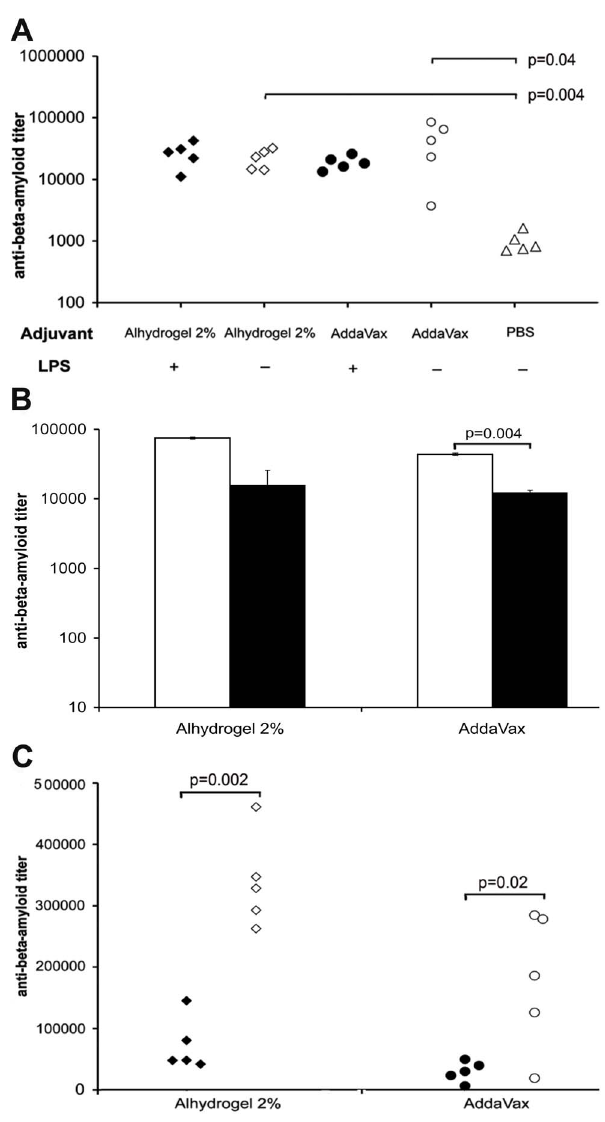
Figure 2. Titer and isotype of anti-A b antibodies induced by (1– 11)E2 formulated in Alhydrogel 2% or AddaVax. panel a The plot reports the anti-A b antibody titer at day 14 of B6C3/F1 mice that have received one injection of (1–11)E2, formulated in Alhydrogel 2% (diamonds), AddaVax (circles), or without adjuvant (triangles). Each symbol represents a mouse. Some mice were immunized with LPS-free (1–11)E2 (open symbols) while other mice were immunized with (1– 11)E2 obtained with the standard purification protocol (closed symbols). With either adjuvant, the presence of LPS contamination in the (1–11)E2 preparation has no statistically significant effect on the anti-A b titer. Both Alhydrogel 2% and AddaVax significantly enhanced the anti-A b response induced by LPS-free (1–11)E2, with no significant difference in the anti-A b IgG titer obtained with Alhydrogel 2%, or AddaVax. panel b The histograms show the anti-A b titer of IgG1 (white bars) and IgG2a (black bars) isotype antibodies in the pooled sera of B6C3/F1 mice (n=5 in each treatment group) vaccinated with LPS-free (1–11)E2, formulated in the indicated adjuvants. Sera were collected at day 109. The error bars represent the standard deviation, calculated from extreme alternative fit lines. IgG1 antibodies were more abundant than IgG2a in both the Alhydrogel 2% and the AddaVax group. panel c The graph shows the anti-A b (1–11) IgG titer in the sera of B6C3/F1 mice immunized with (1–11)E2 formulated in either Alhydrogel 2% or AddaVax. Mice received 3 doses of adjuvanted vaccine, at day 0, 15 and 238. Sera were collected before the day 238 recall dose (black